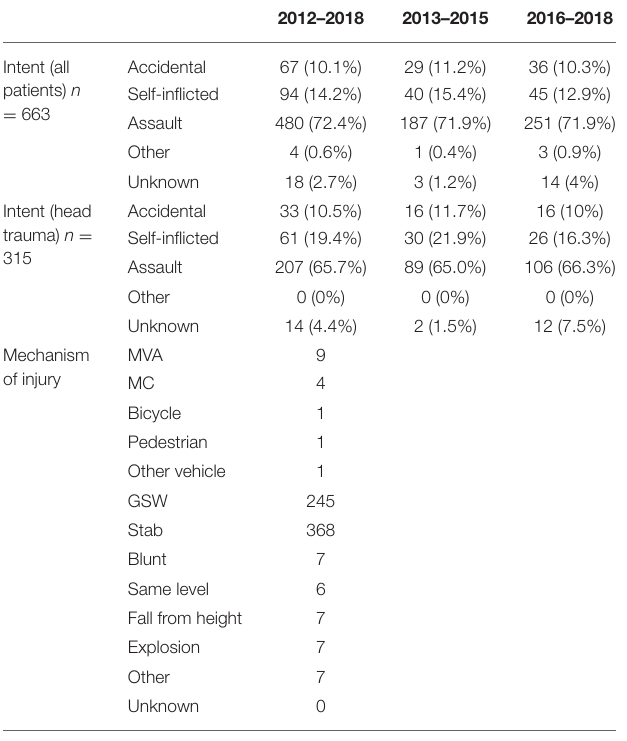
TABLE 2 | Intent and injury mechanism for all and head trauma patients.